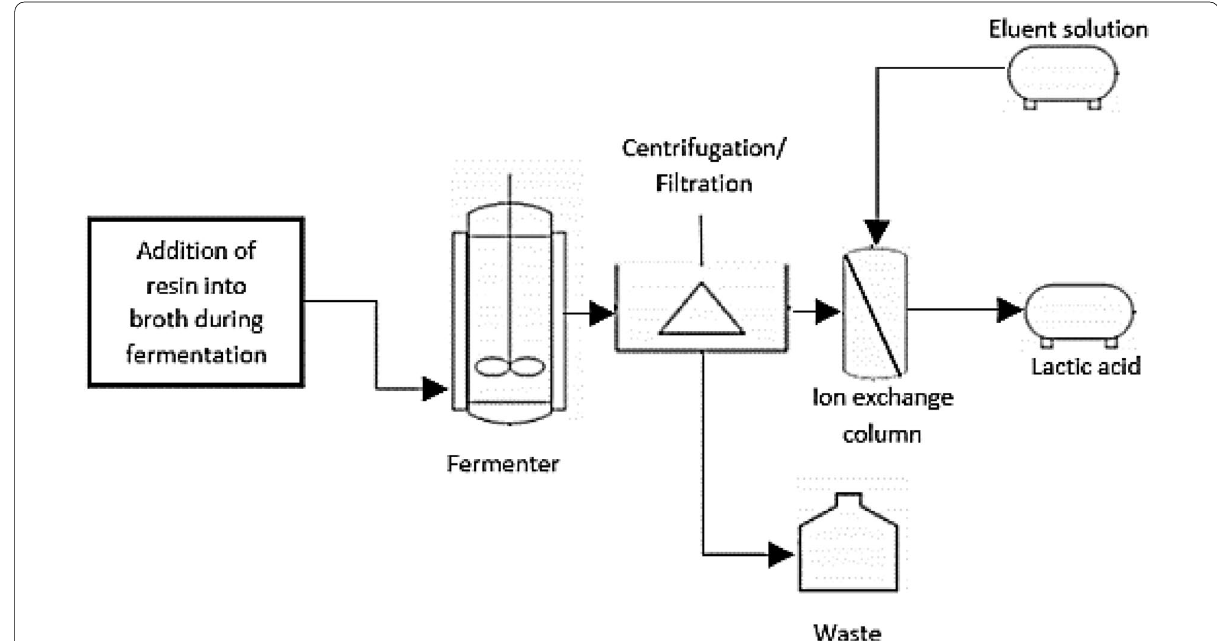
Fig. 2 In-site ion exchange separation of lactic acid from fermentation